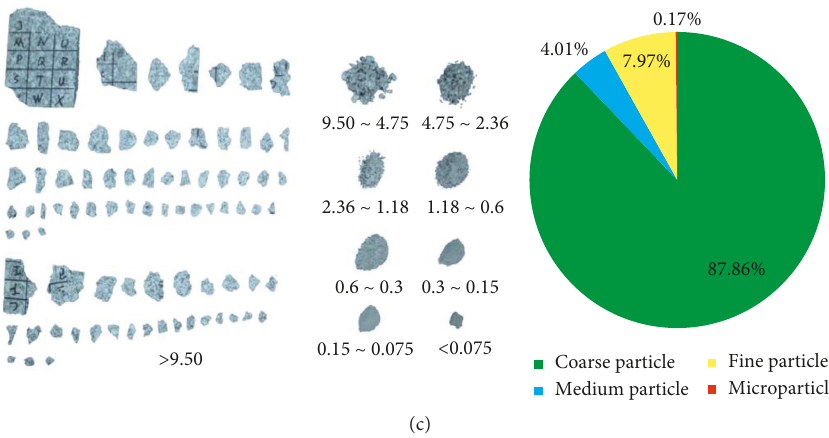
Figure 16: The size distribution of the fragments under different support failure timings (unit: mm): (a) σ 90%. (c) σ 1 / σ max (cid:31)